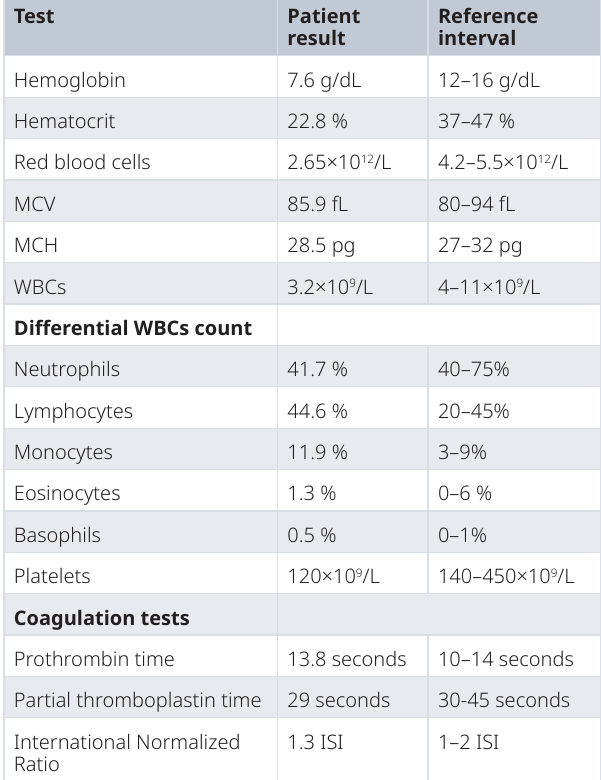
Table 1. Complete blood count (CBC), differential white blood cells (WBCs) count and coagulation tests. Test Patient